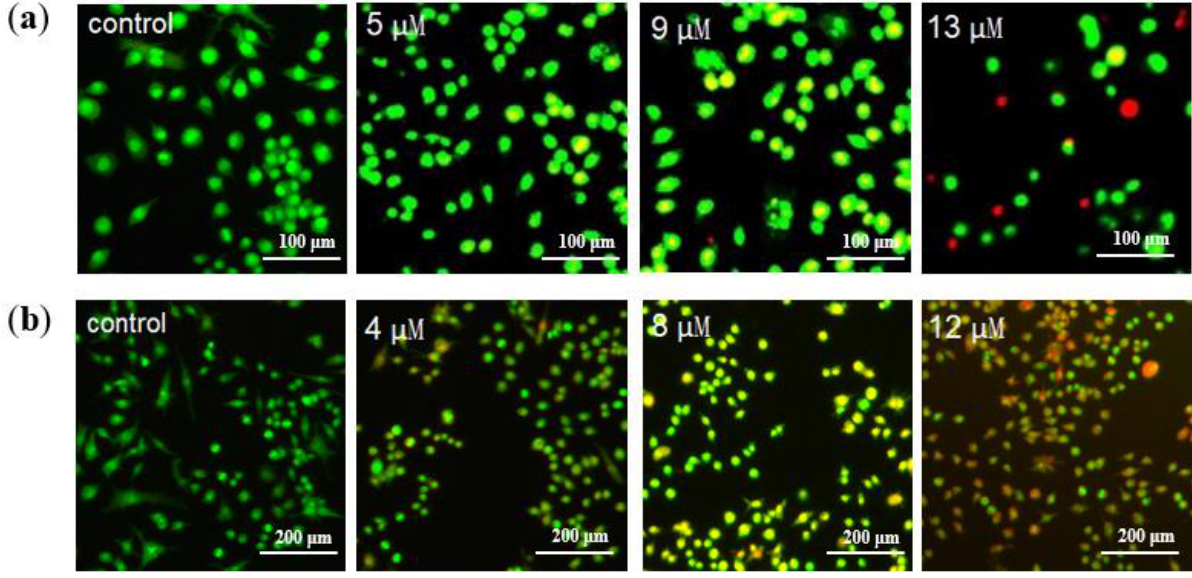
Figure 3. Changes in morphology of AO/EB double-stained BGC-823 cells treated with ( a ) 10a (5 μM, 9 μM, and 13 μM) for 24 h and ( b ) 10f (4 μM, 8 μM, and 12 μM) for 24 h .